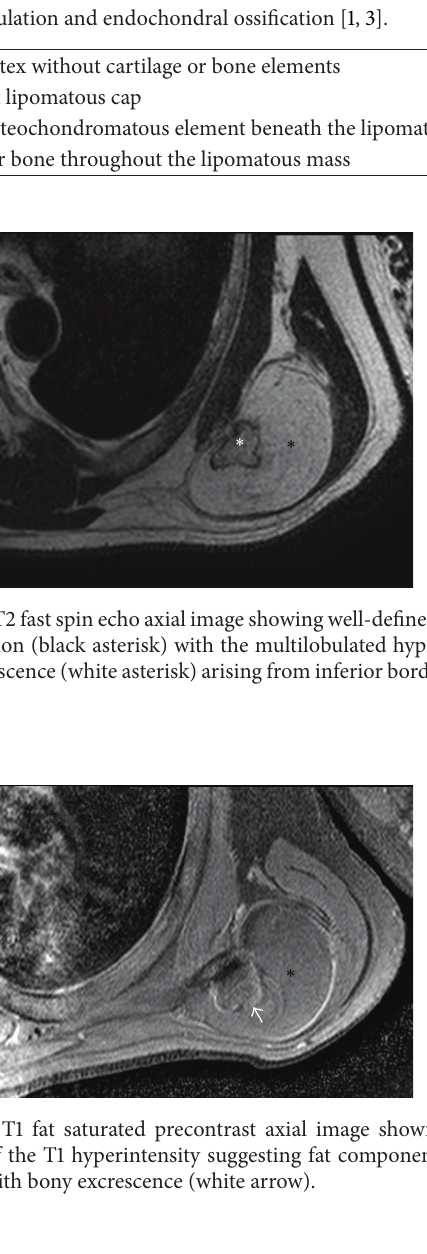
Figure 2: T1 fast spin echo coronal image of left shoulder joint showing well-defined, juxtacortical, and hyperintense lesion (black asterisk) with the multilobulated hypointense bony excrescence (white asterisk) and several thin low signal striations (white arrow) noted arising from inferior border of left scapula.